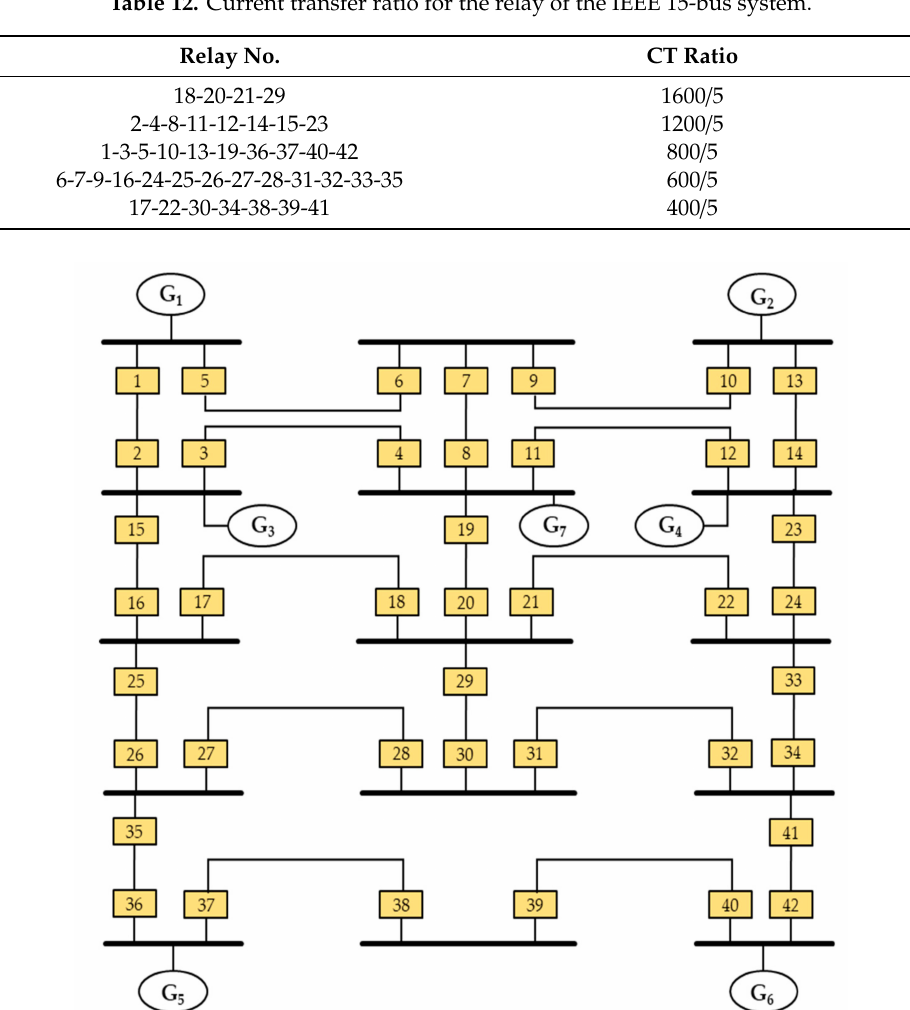
Figure 9. Diagram of the IEEE 15-bus